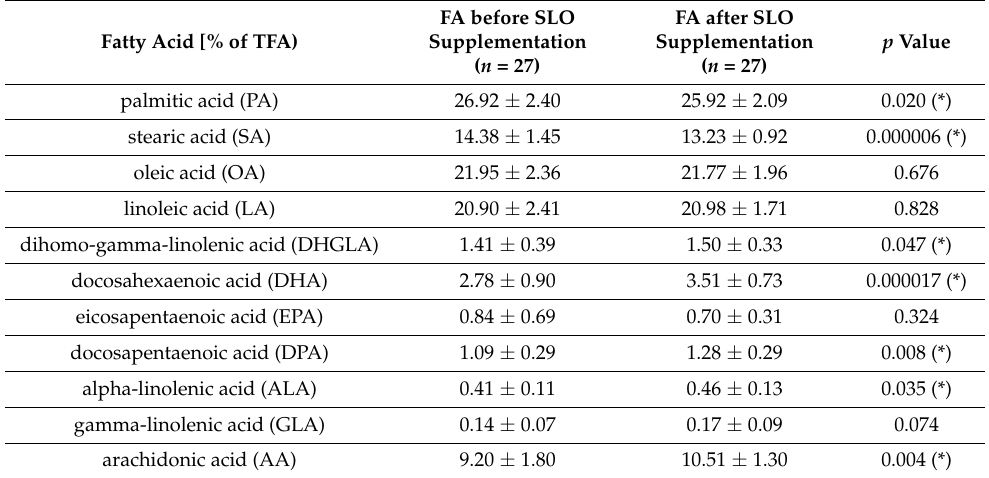
Table 2. Erythrocyte FA profile in study participants before and after 6 weeks of SLO supplementation.